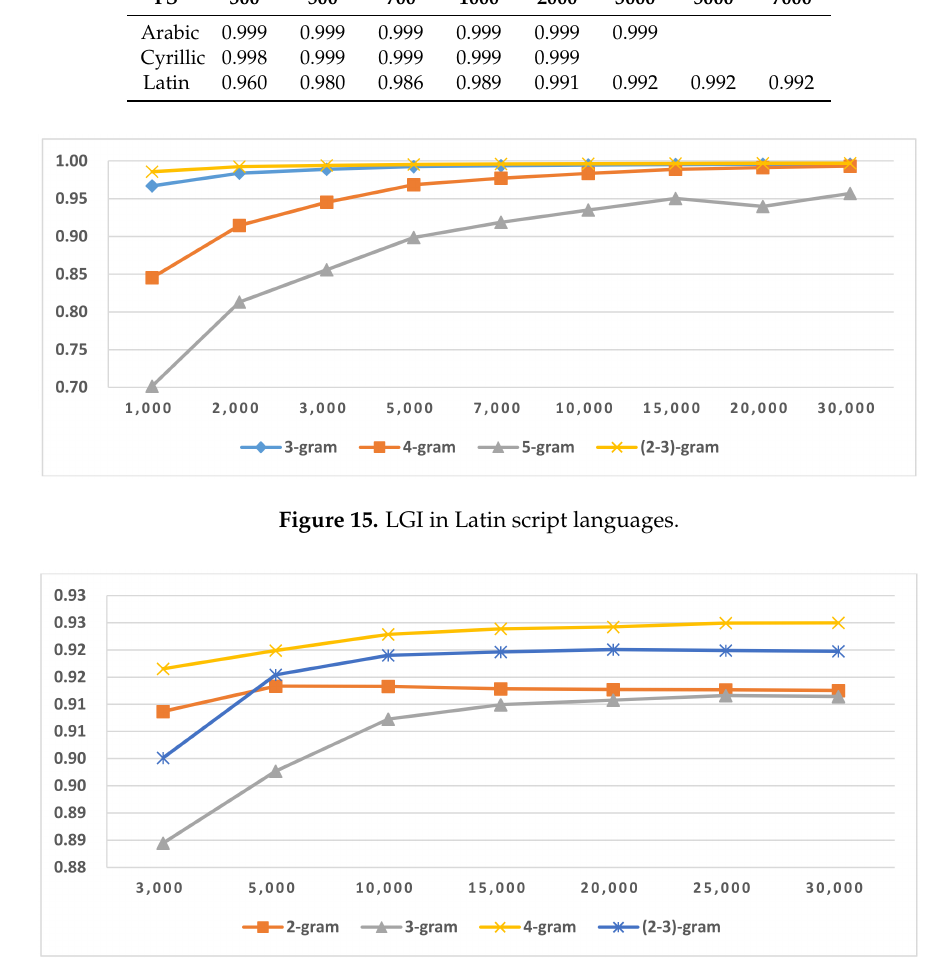
Figure 16. LI in Indo-European/Germanic in Latin script languages.